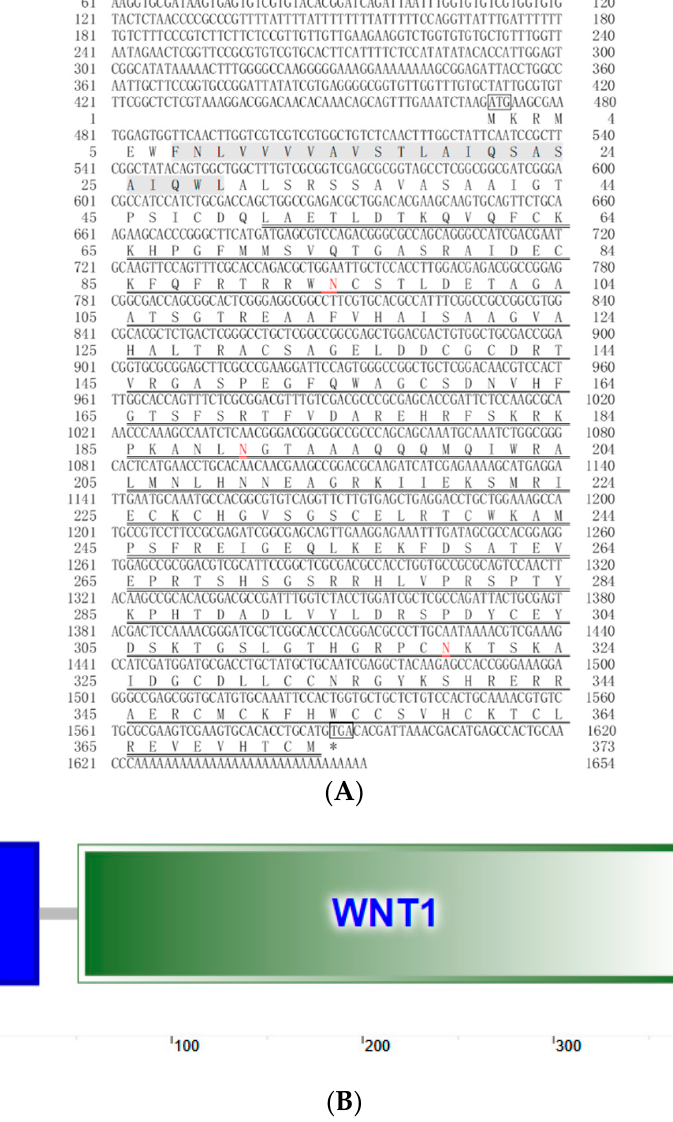
Figure 1. Nucleotide and deduced amino acid sequences of DpWnt4 ( A , B ). Start (ATG) and stop (TGA/TAA) codons are marked with boxes. The transmembrane region is shaded (blue rectangle in ( B ). The Wnt1 domain is indicated by double underlines. The N-glycosylation sites are highlighted in red.